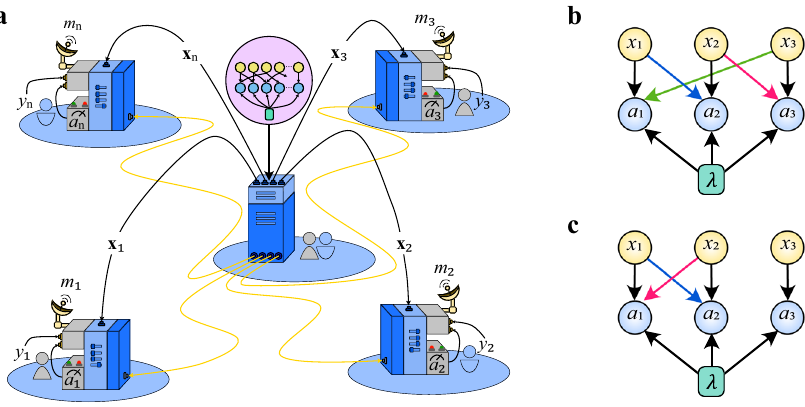
Fig. 1 Distributed computation in a CCP scenario. a A central agent allocates resources among a network of n users who independently produce outcomes to solve a collective task. Each user i receives y i and a subset x i of the variables x 1 ; (cid:3)(cid:3)(cid:3) ; x n f g according to some underlying causal structure indicated by the shaded pink region. Each user processes their input data along with shared correlations and broadcast a one- bit message m i to all others before they compute a function f ( x 1 , … , x n , y 1 , … , y n ). When allowing for quantum resources, shared quantum correlations that violate a Bell-like inequality bounding the corresponding NLHV model provide an advantage in the probability of success of the task over its classical counterpart. b Causal structure of the three-party GYNI scenario 41,49 experimentally investigated. The input of each party x i is communicated to its neighbour to the right (or alternatively, to the left). The variable λ stands for pre-shared (classical) correlations shared among the parties and used to produces respective outcomes, a i . c Causal structure of Svetlichny ’ s scenario 40 as discussed in Supplementary